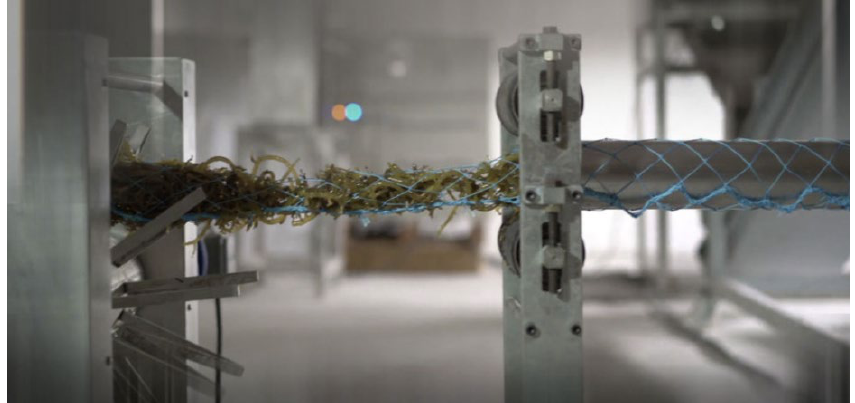
Figure 17. Linear net seeding— Sea6Energy — (https://www.sea6energy.com/automated-farming Figure 17. linear net seeding — Sea6Energy— (https://www.sea6energy.com/automated-farming (ac- (accessed on 22 September cessed on 22 September 2022)).